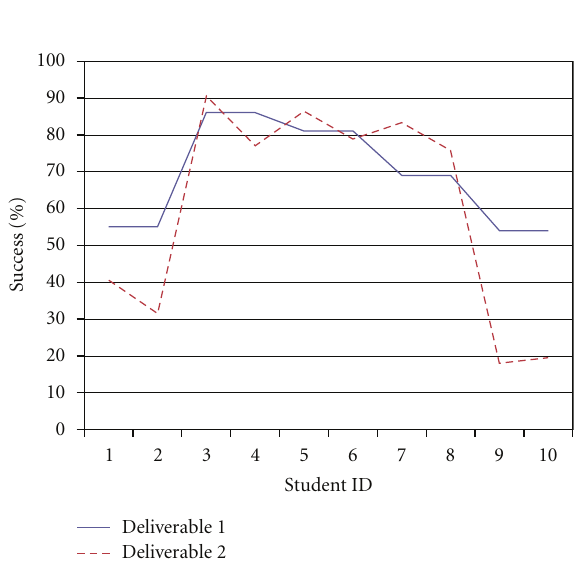
Figure 10: Modelsim simulation.